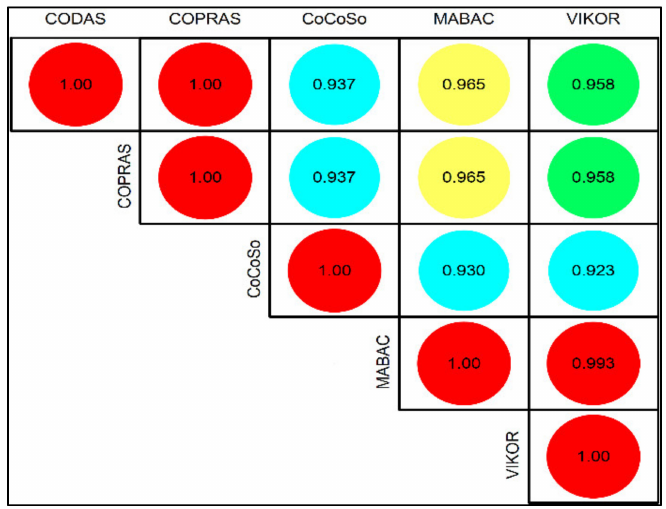
Figure 1. Correlation matrix of the ranks obtained using various